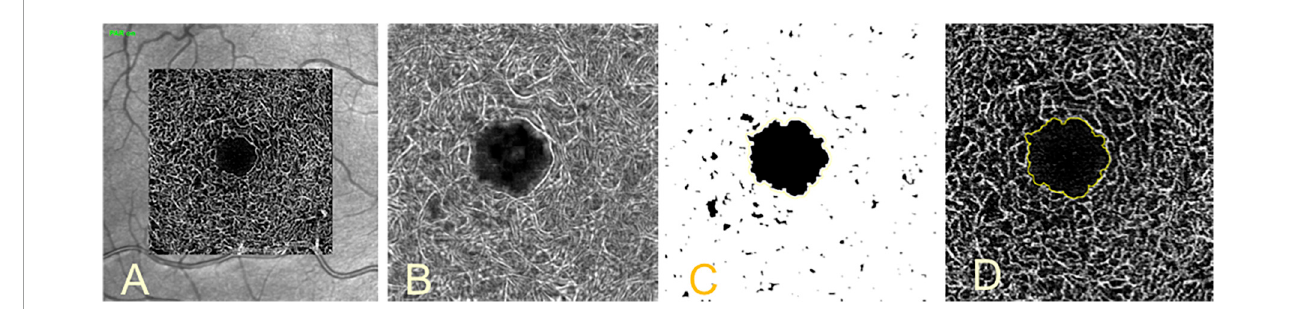
FIGURE3 Segmentation of the foveal avascular zone (FAZ). Image of the intermediate vascular plexus image (A) , same image after noise reduction, zoom and vessel-amplification using Gabor edge filters (B) , isolated FAZ after thresholding segmentation (C) , segmented FAZ in yellow outline in unedited image (D)